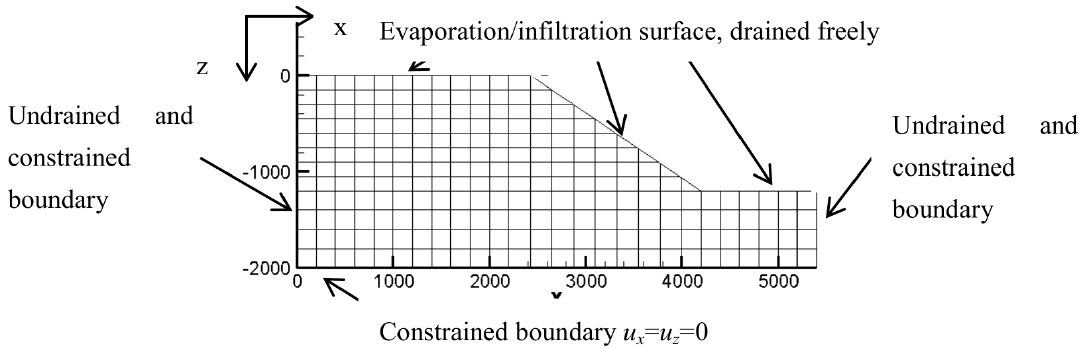
Figure 1. Computational mesh and boundary conditions.